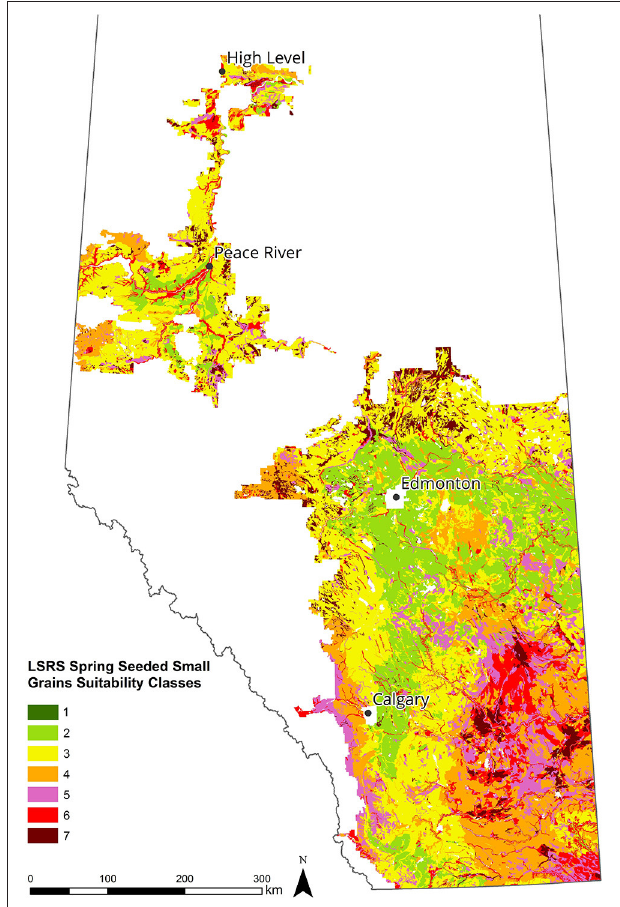
FIGURE 7 | LSRS class ratings for spring-seeded small grains based on the 1981–2010 climate normal intersected and displayed on a:100,000 scale soil map of the agricultural region of